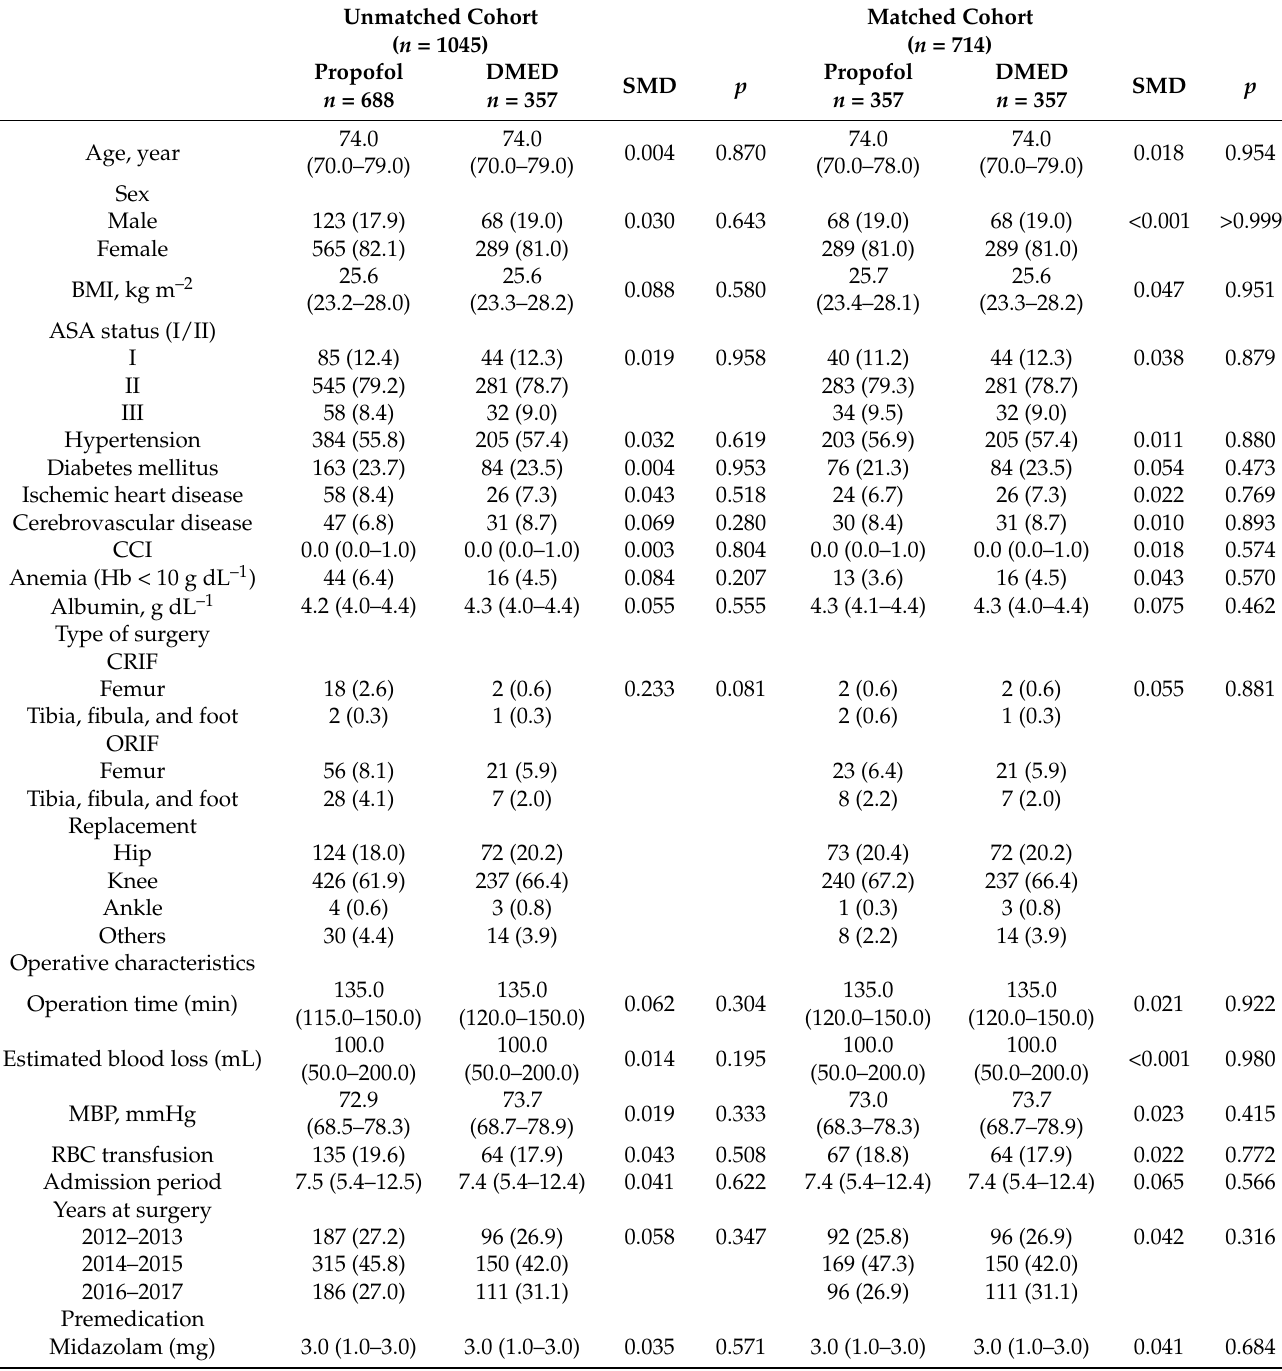
Table 1. Baseline characteristics before and after propensity score